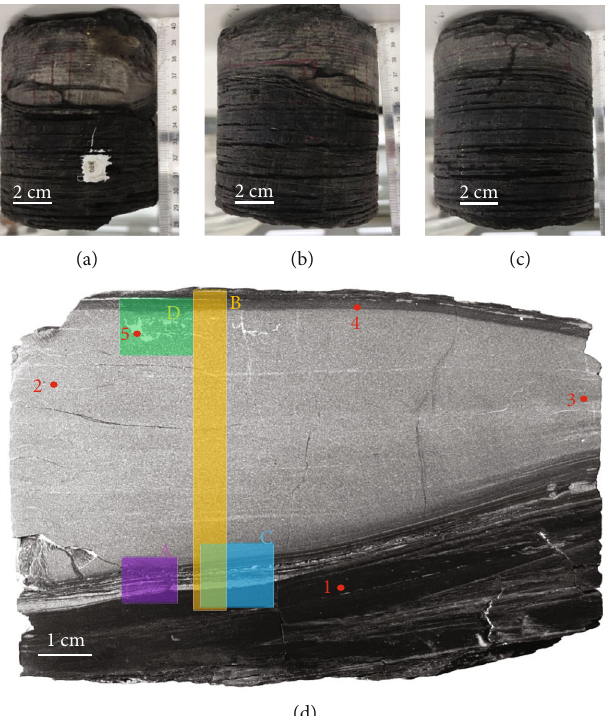
Figure 1: Dolomite nodule encased by black shale from front (a), side (b), rear (c), and sectional (d) views. Area A in (d) covering the transitional zone between dolomite nodule and host black shale was observed by using optical microscopy. Five points (1-5) in the sectional surface in (d) were selected to do single-point μ -XRF analysis and parameter optimization. The whole sectional surface and areas B-D were scanned with resolutions of 25 μ m and 10 μ m, respectively, by using μ